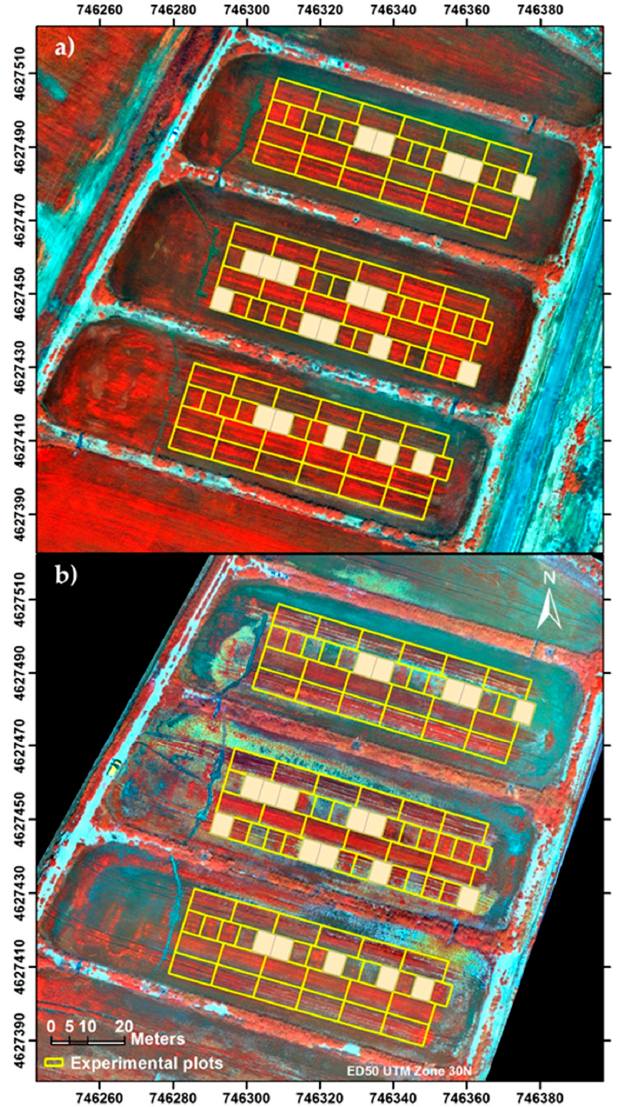
Figure 1. Experimental plots layout (yellow lines) superimposed on the images (false color RGB: Near-Infrared band/ Green band/ Red band) taken with a multispectral camera at the booting stage, 30 July 2012 ( a ) and 13 August 2013 ( b ). The shaded areas represent additional treatments excluded from the analysis in this paper.